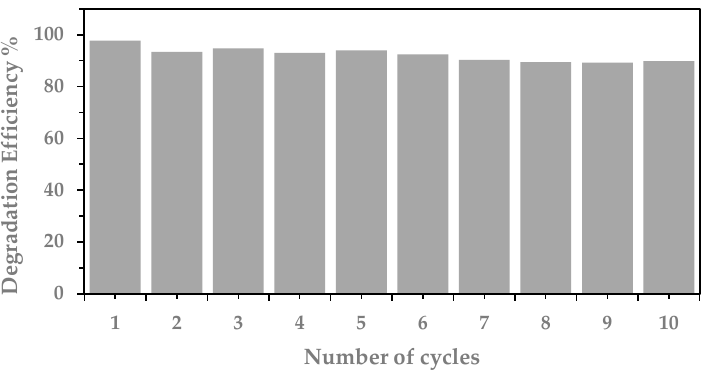
Figure 10. Reusability of TC50 photocatalyst in the MO degradation under simulated solar irradiation.